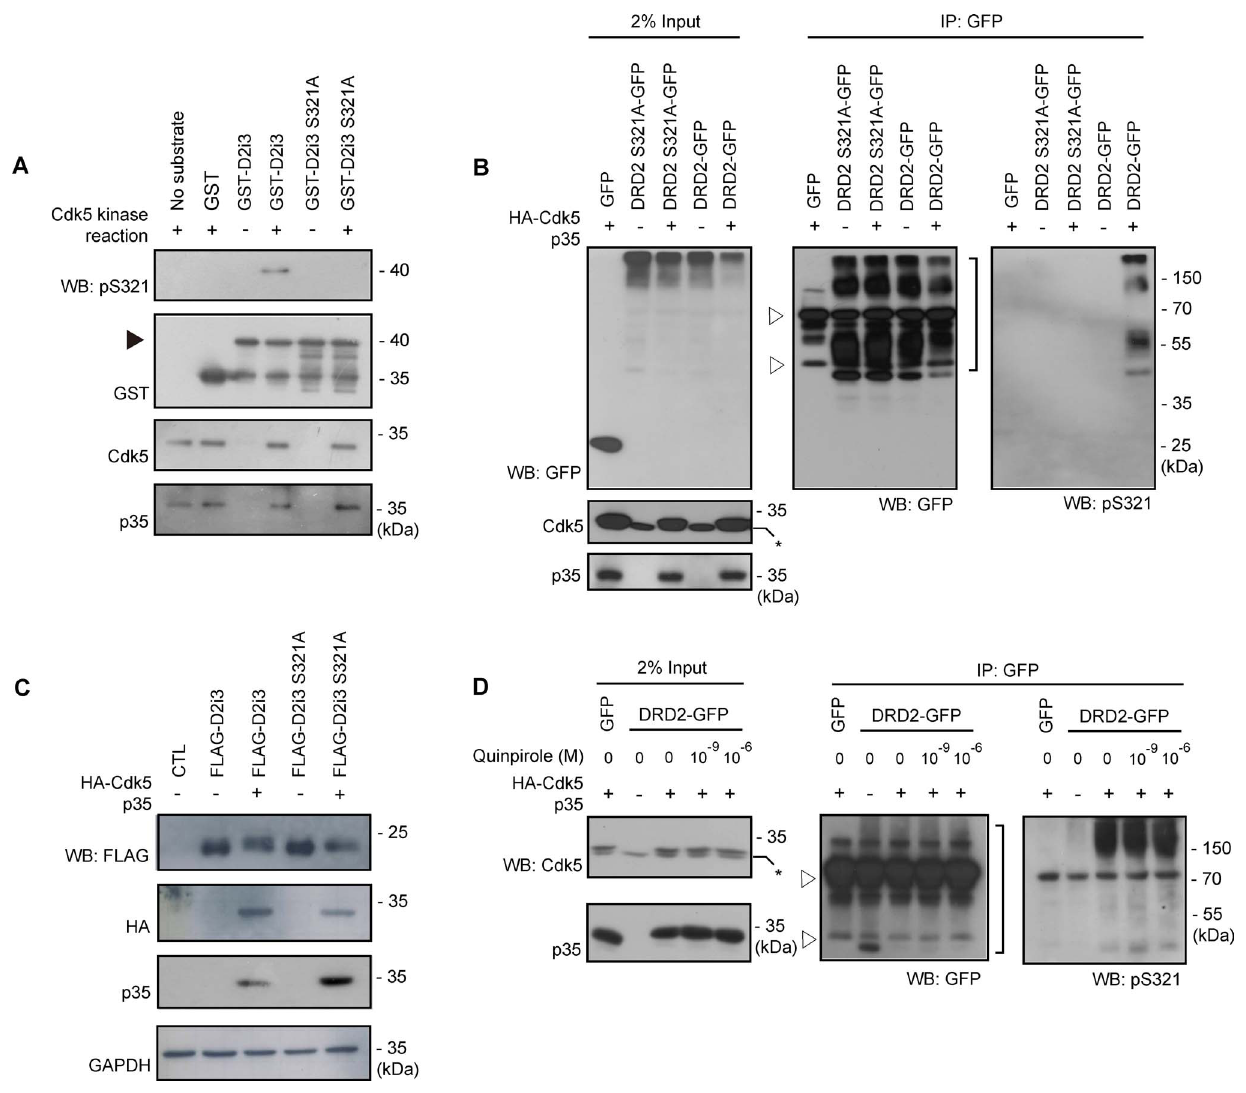
Figure 2. Cdk5 phosphorylates serine 321 in the third intracellular loop of DRD2 in cells. Cdk5-mediated phosphorylation of serine 321 was analyzed using anti-pS321 antibody. (A) Samples from IP-linked in vitro kinase assay using GST-D2i3 proteins were analyzed by Western blotting (WB) with indicated antibodies. Arrowheads indicate GST-D2i3s. (B) DRD2-GFP and DRD2 S321A-GFP was expressed with or without HA-Cdk5 and p35 in HEK 293 cells. Anti-GFP immunoprecipitates were analyzed by Western blotting using anti-GFP and anti-pS321 antibodies. The bracket indicates DRD2 signals and open arrowhead indicates nonspecific signals from the anti-GFP immunoprecipitates. ‘% input’ is % volume of total lysate for an IP reaction. Weak endogenous Cdk5 signals were indicated by asterisks. (C) Gel mobility shift assay. HEK 293 cells transfected as indicated were analyzed by Western blotting. (D) Transfected HEK 293 cells were treated with quinpirole and anti-GFP immunoprecipitates were analyzed by Western blotting with anti-GFP and anti-pS321 antibodies. Open arrowhead indicates nonspecific signals from anti-GFP